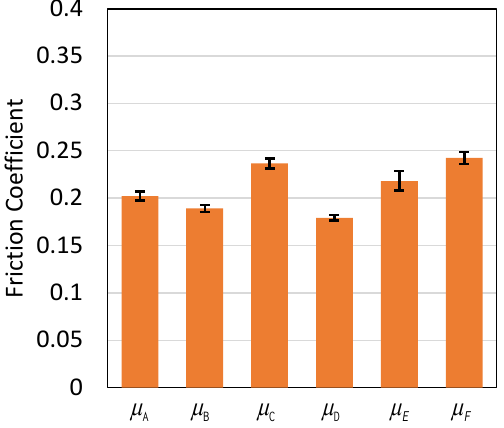
Figure 7. Physical properties. Average value and standard deviation of coefficient of friction of four objects shown in Figure 5a.